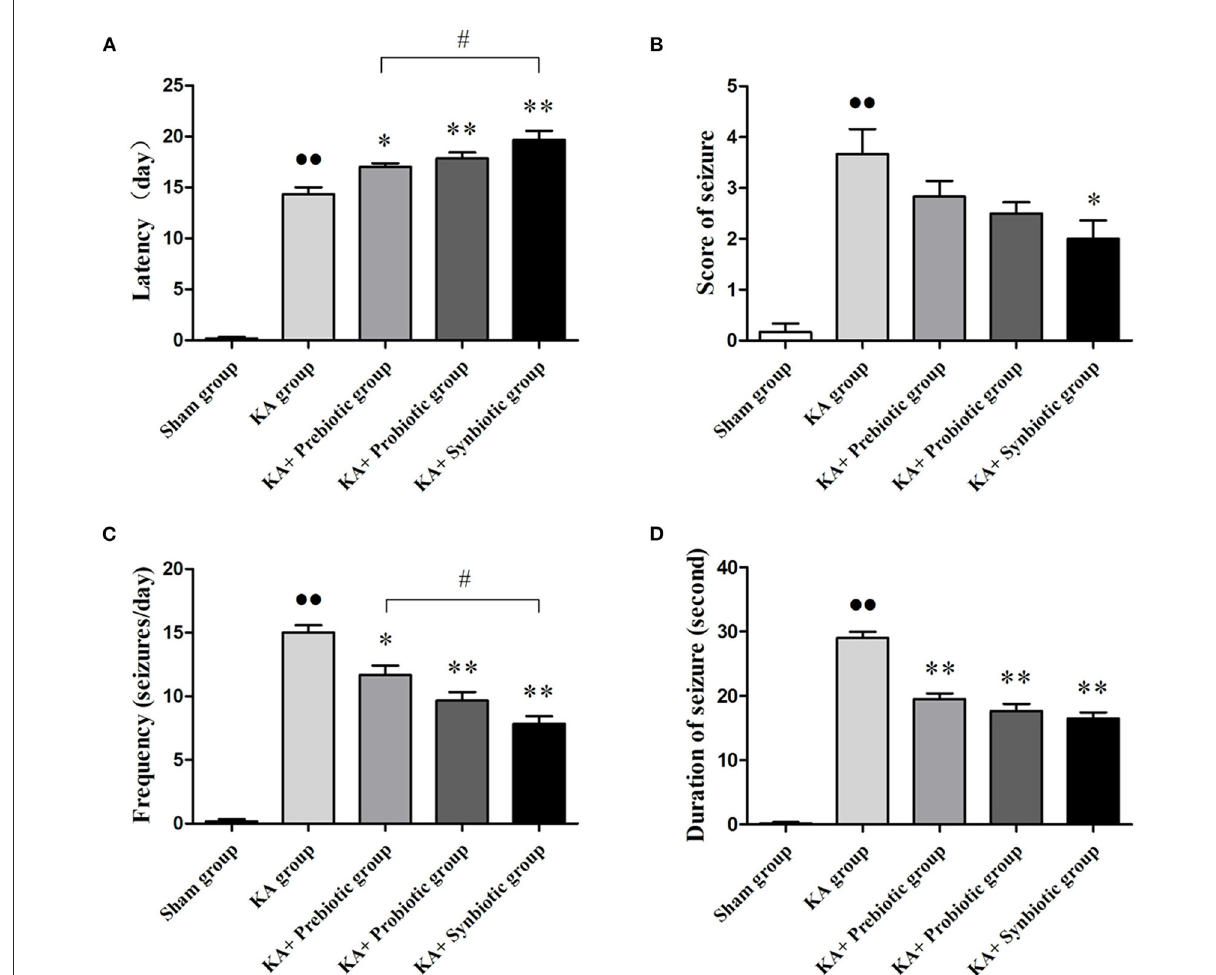
FIGURE1 Effect of prebiotics, probiotics, and synbiotics on spontaneous seizures in rats following status epilepticus induction. (A) Latency. (B) Scores of seizures. (C) Frequency of seizures. (D) Duration of seizures. •• P < 0.01 vs. the Sham group, * P < 0.05 vs. the KA group, ** P < 0.01 vs. the KA group, # P < 0.05 vs. the KA + synbiotic group. KA, kainic